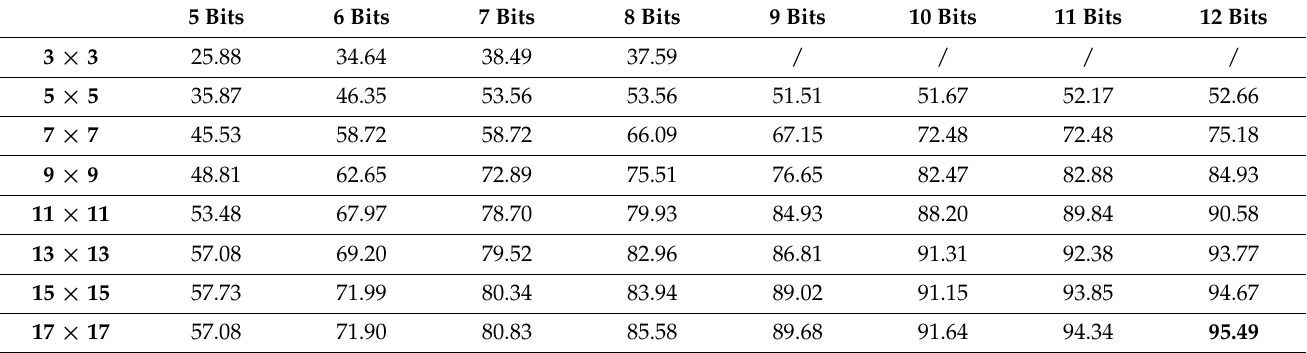
Table 3. Identification accuracies using all BSIF parameters applied to the IITD